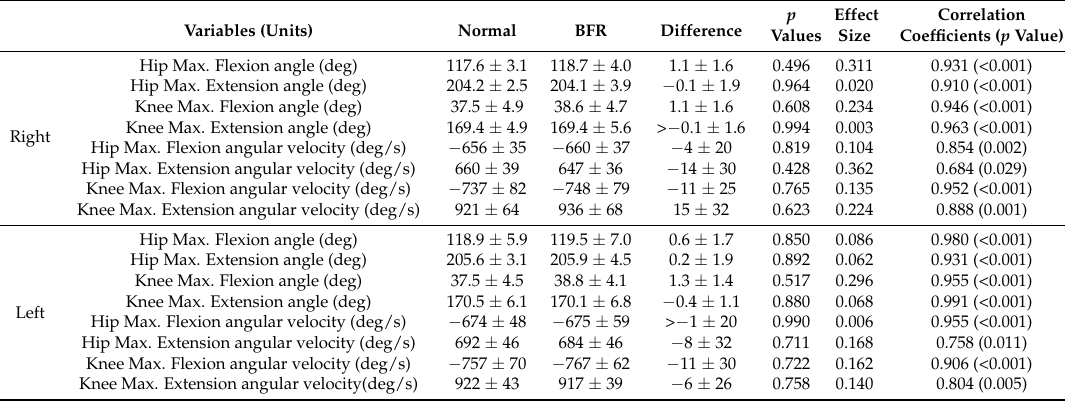
Table 3. Hip and knee maximum flexion and extension angles and angular velocities during a stride cycle and corresponding difference, p -value of a t -test, effect size (Cohen’s d), and correlation coefficients between normal and BFR